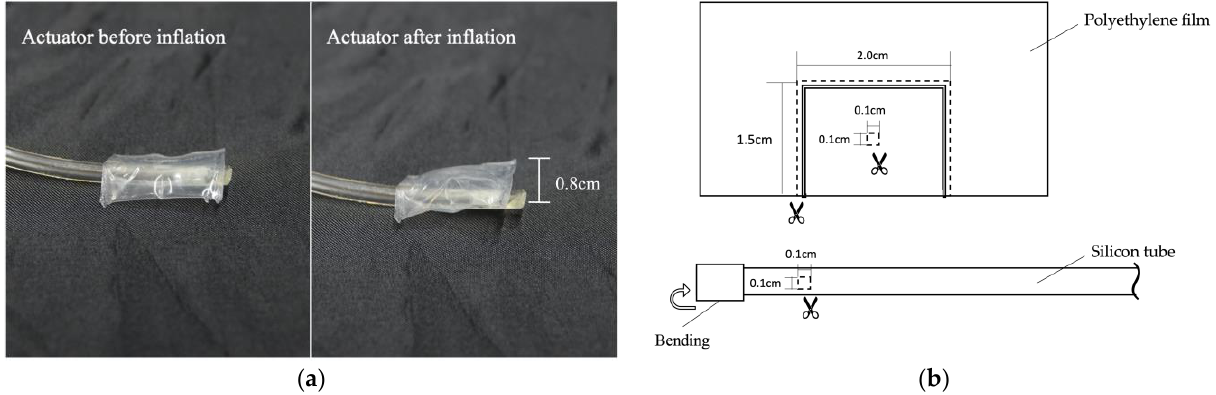
Figure 2. Fabricated pneumatic actuator. ( a ) A working fabricated pneumatic actuator. ( b ) Blueprint of the pneumatic actuator.